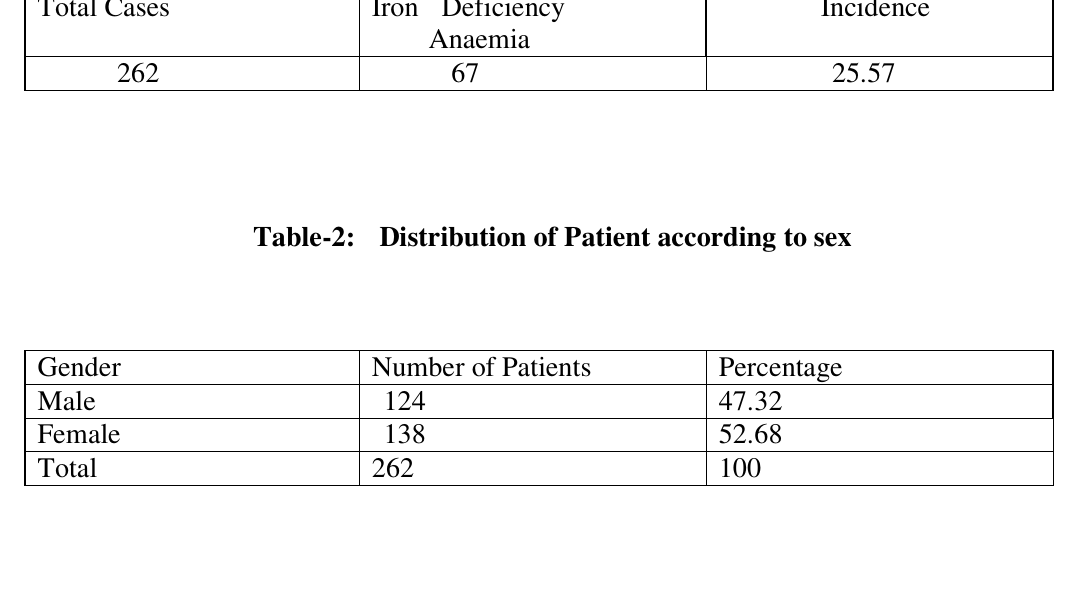
Table-3: Prevalence of Iron Deficiency Anaemia according to sex.